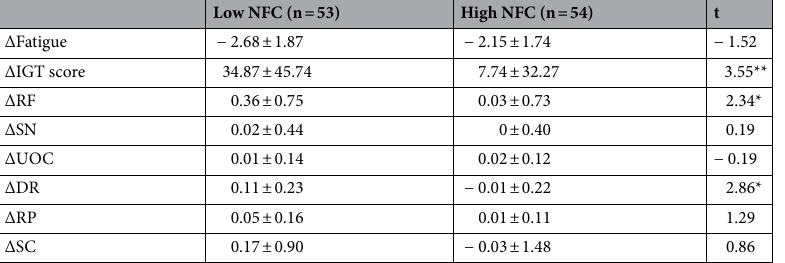
Table 3. Changes in fatigue, IGT scores, and A-DMC in Low and High NFC groups. IGT Iowa Gambling Task, RF resistance to framing, SC resistance to sunk costs, RP consistency in risk perception, SN recognizing social norms, DR applying decision rules, UOC under/overconfidence. *p < 0.05; **p < 0.01.